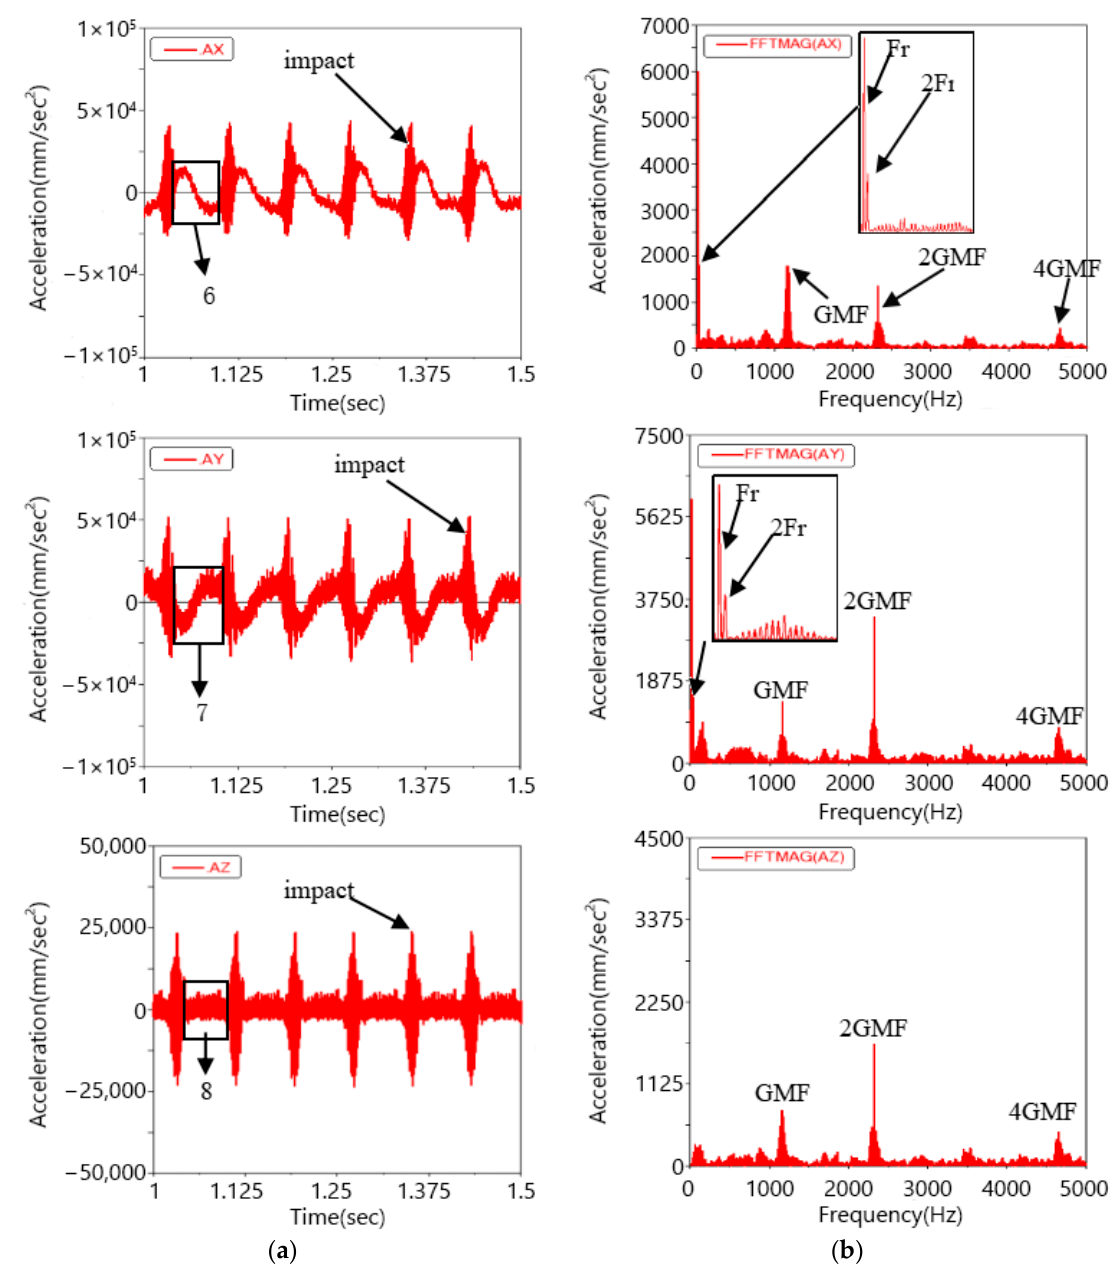
Figure 12. Full broken tooth: ( a ) vibration acceleration and ( b ) its frequency spectrum in x direction.